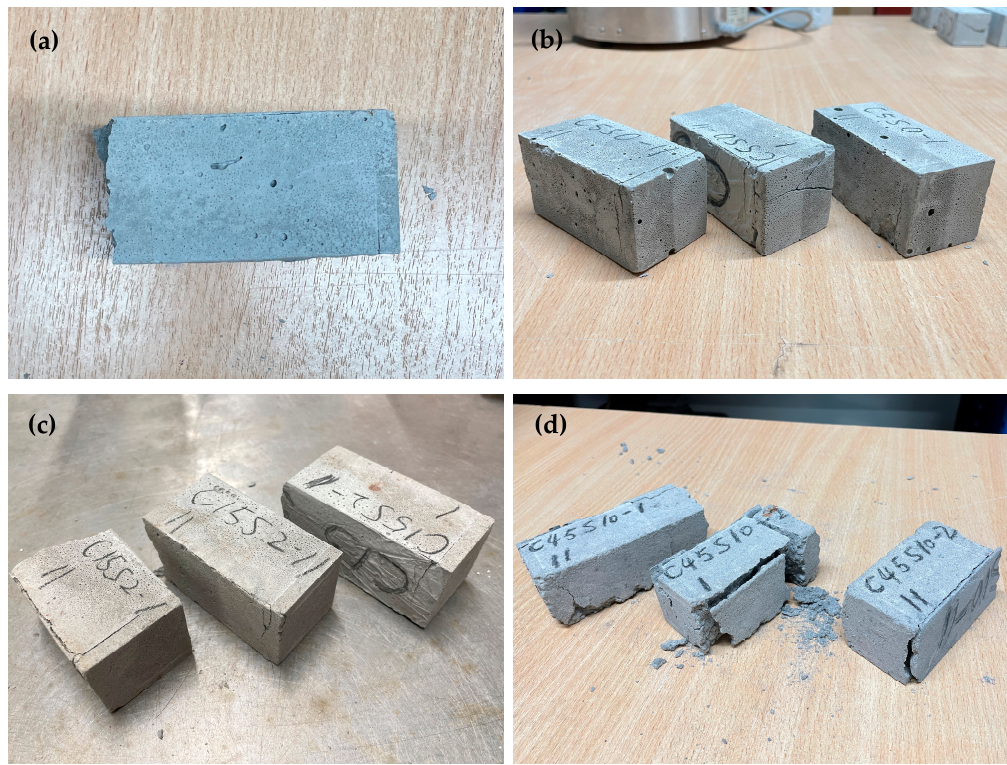
Figure 8. Degradation of representative specimens after compressive test: ( a ) RS; ( b ) C5S0; ( c ) C15S2; ( d ) C45S10.